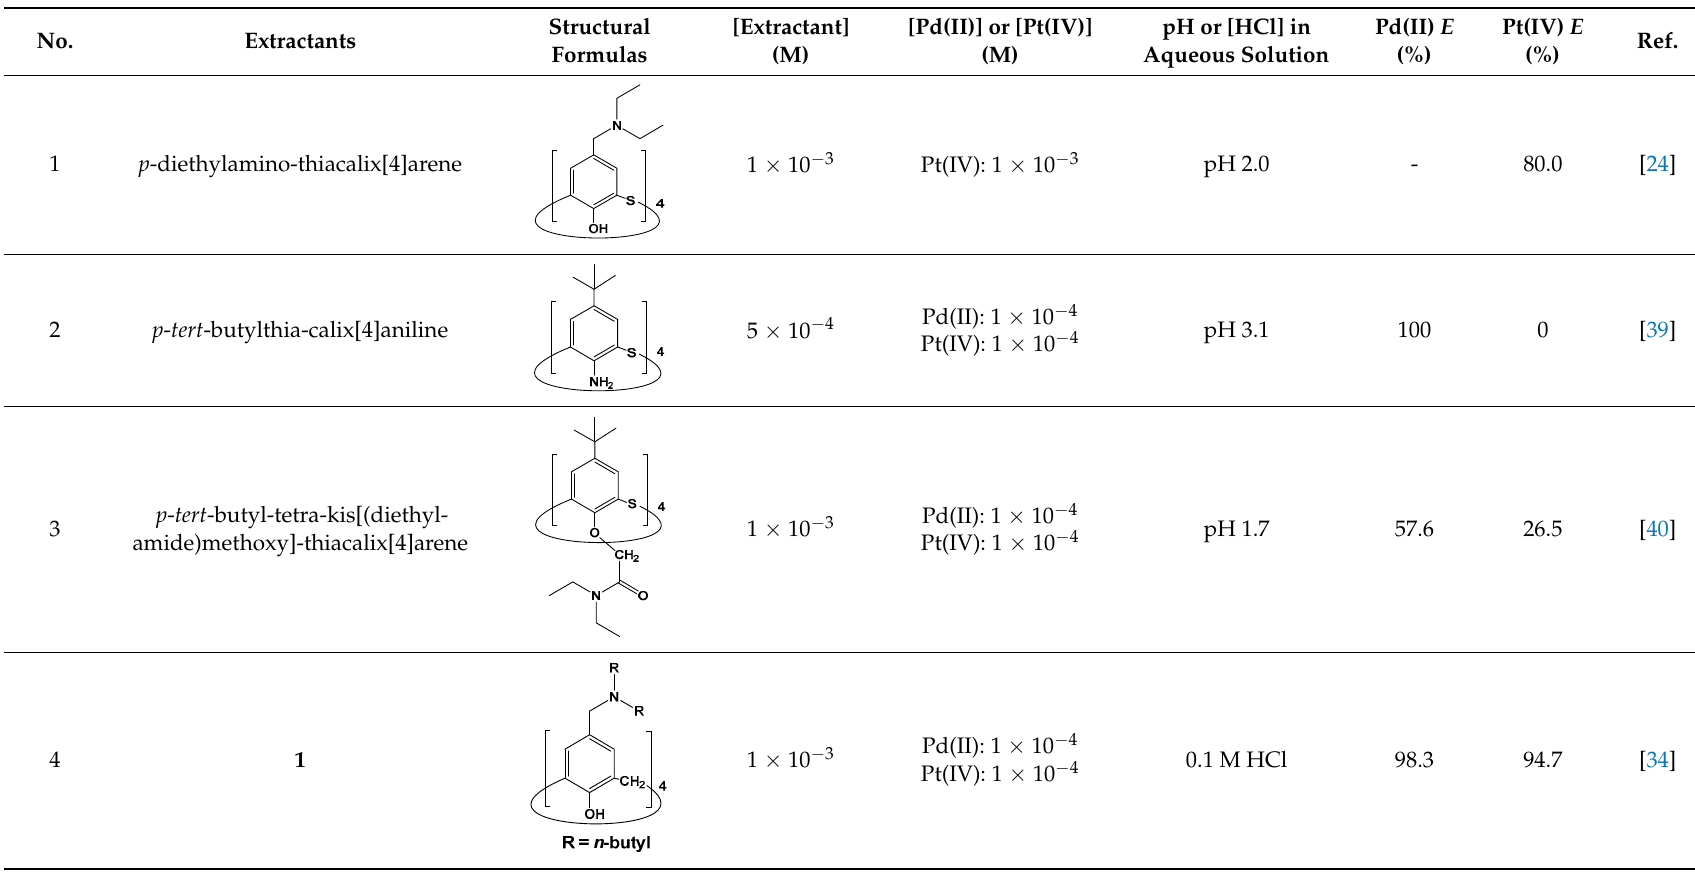
Table 1. A comparison of Pd(II) and Pt(IV) extraction percentage of a few reported calix[4]arenes- and thiacalix[4]arene-based amine- or amide-extractants. No.